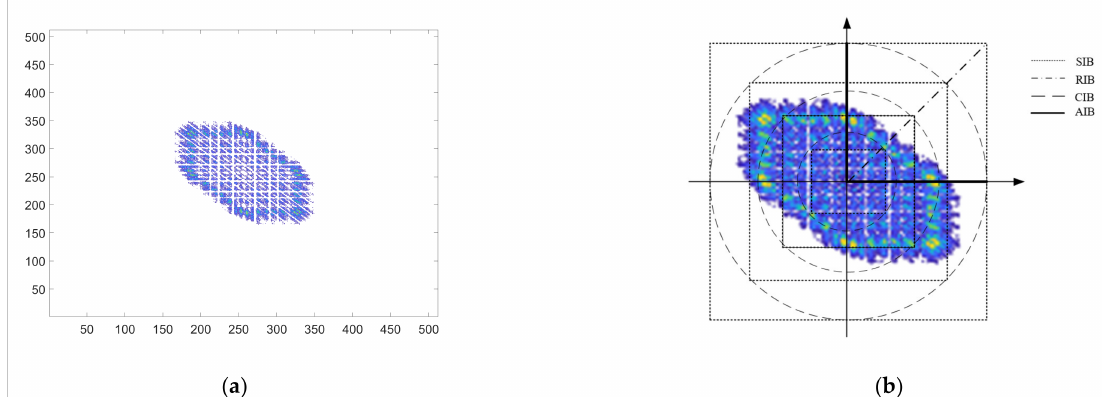
Figure 5. ( a ) Result of bispectral analysis of signal by Emitter 1 under signal-to-noise ratio of 15 dB. ( b ) Four paths for integrating two-dimensional bispectral